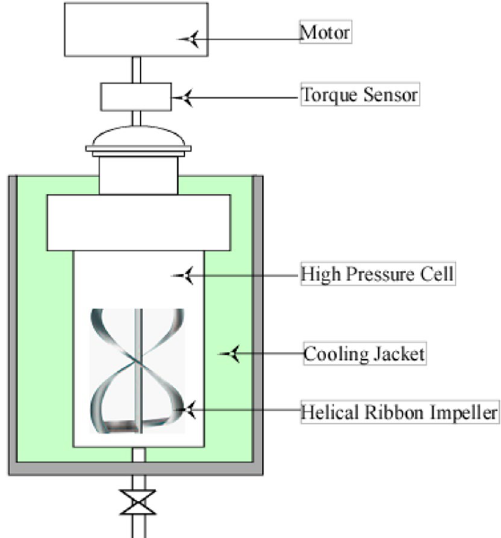
Fig. 9 Schematic of the in-house mixer-viscometer used in charac- terization of hydrate